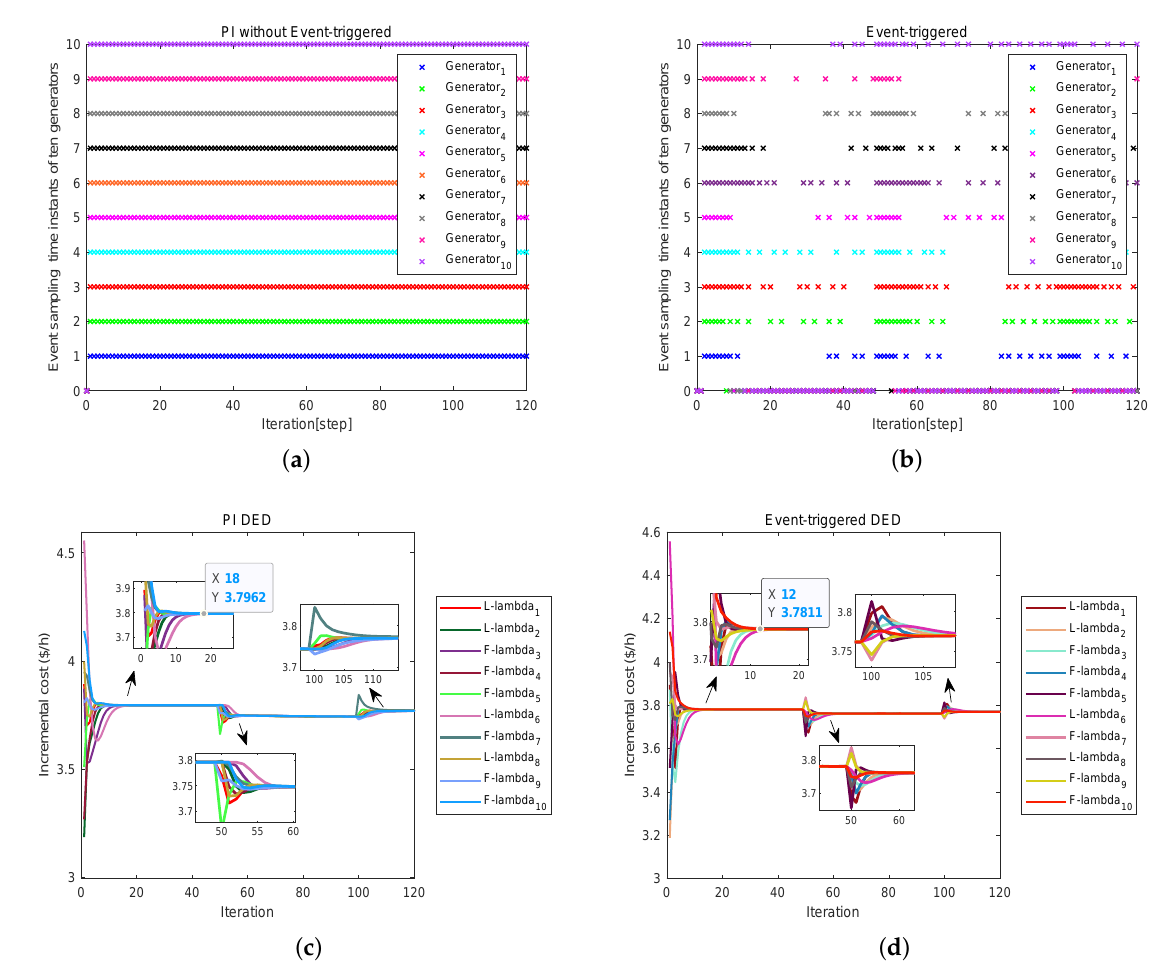
Figure 8. ( a ) PI without event-triggered. ( b ) Event-triggered. ( c ) PI DED. ( d ) Event-triggered DED.